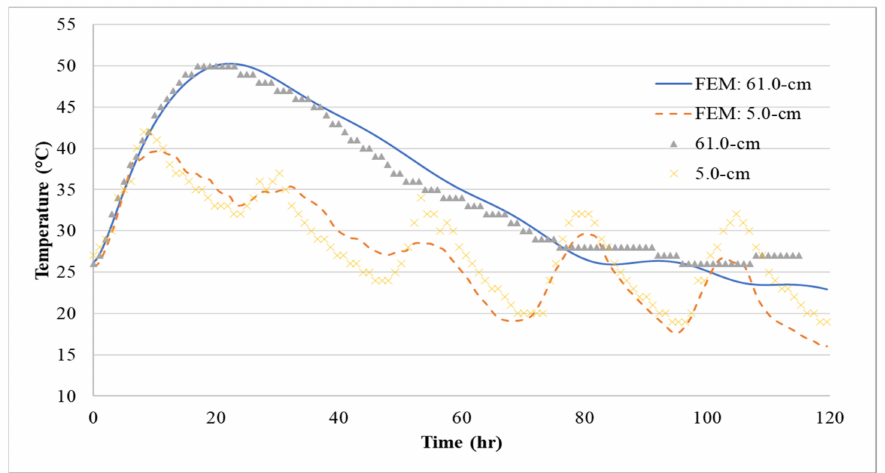
Figure 14. Comparison between FEM model prediction and measured temperatures at center (61.0-cm) and side surface (5.0-cm) for Batch